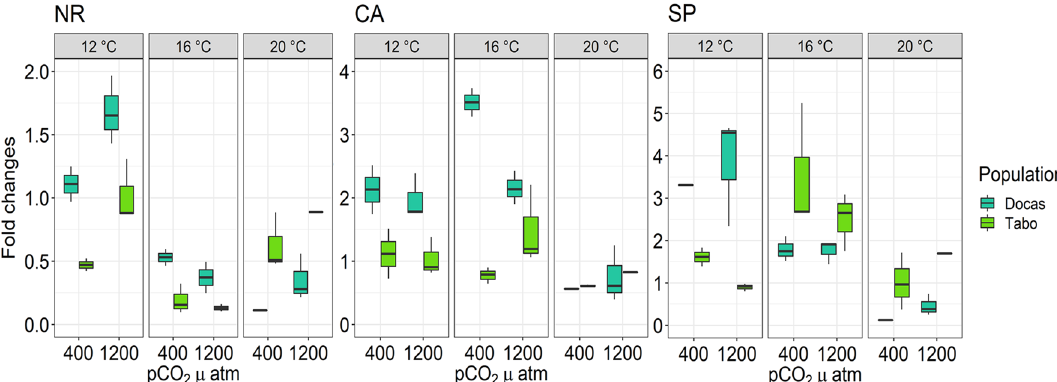
Figure 4. Relative expression levels (fold changes) of the nitrogen and carbon mechanisms related-genes, nitrate reductase (NR) and carbonic anhydrase (CA), and the stress related-gene, spermine (SP), from juvenile Macrocystis sporophytes (Las Docas and El Tabo) exposed to three temperature (12, 16 and 20 °C) and two pCO 2 treatments (~ 400 and 1200 µatm) for three weeks. Box-plots showing median size (line within box), 25th and 75th percentiles (ends of box), and minimum and maximum distribution of the data